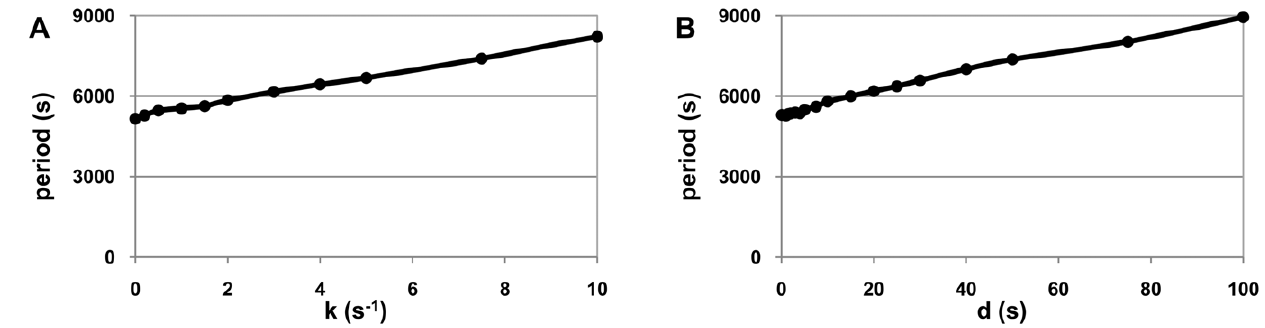
Figure 6. Pausing effects on the period of a genetic oscillator. Average period length of the repressilator as (A) pausing rate, and (B) pause duration vary.